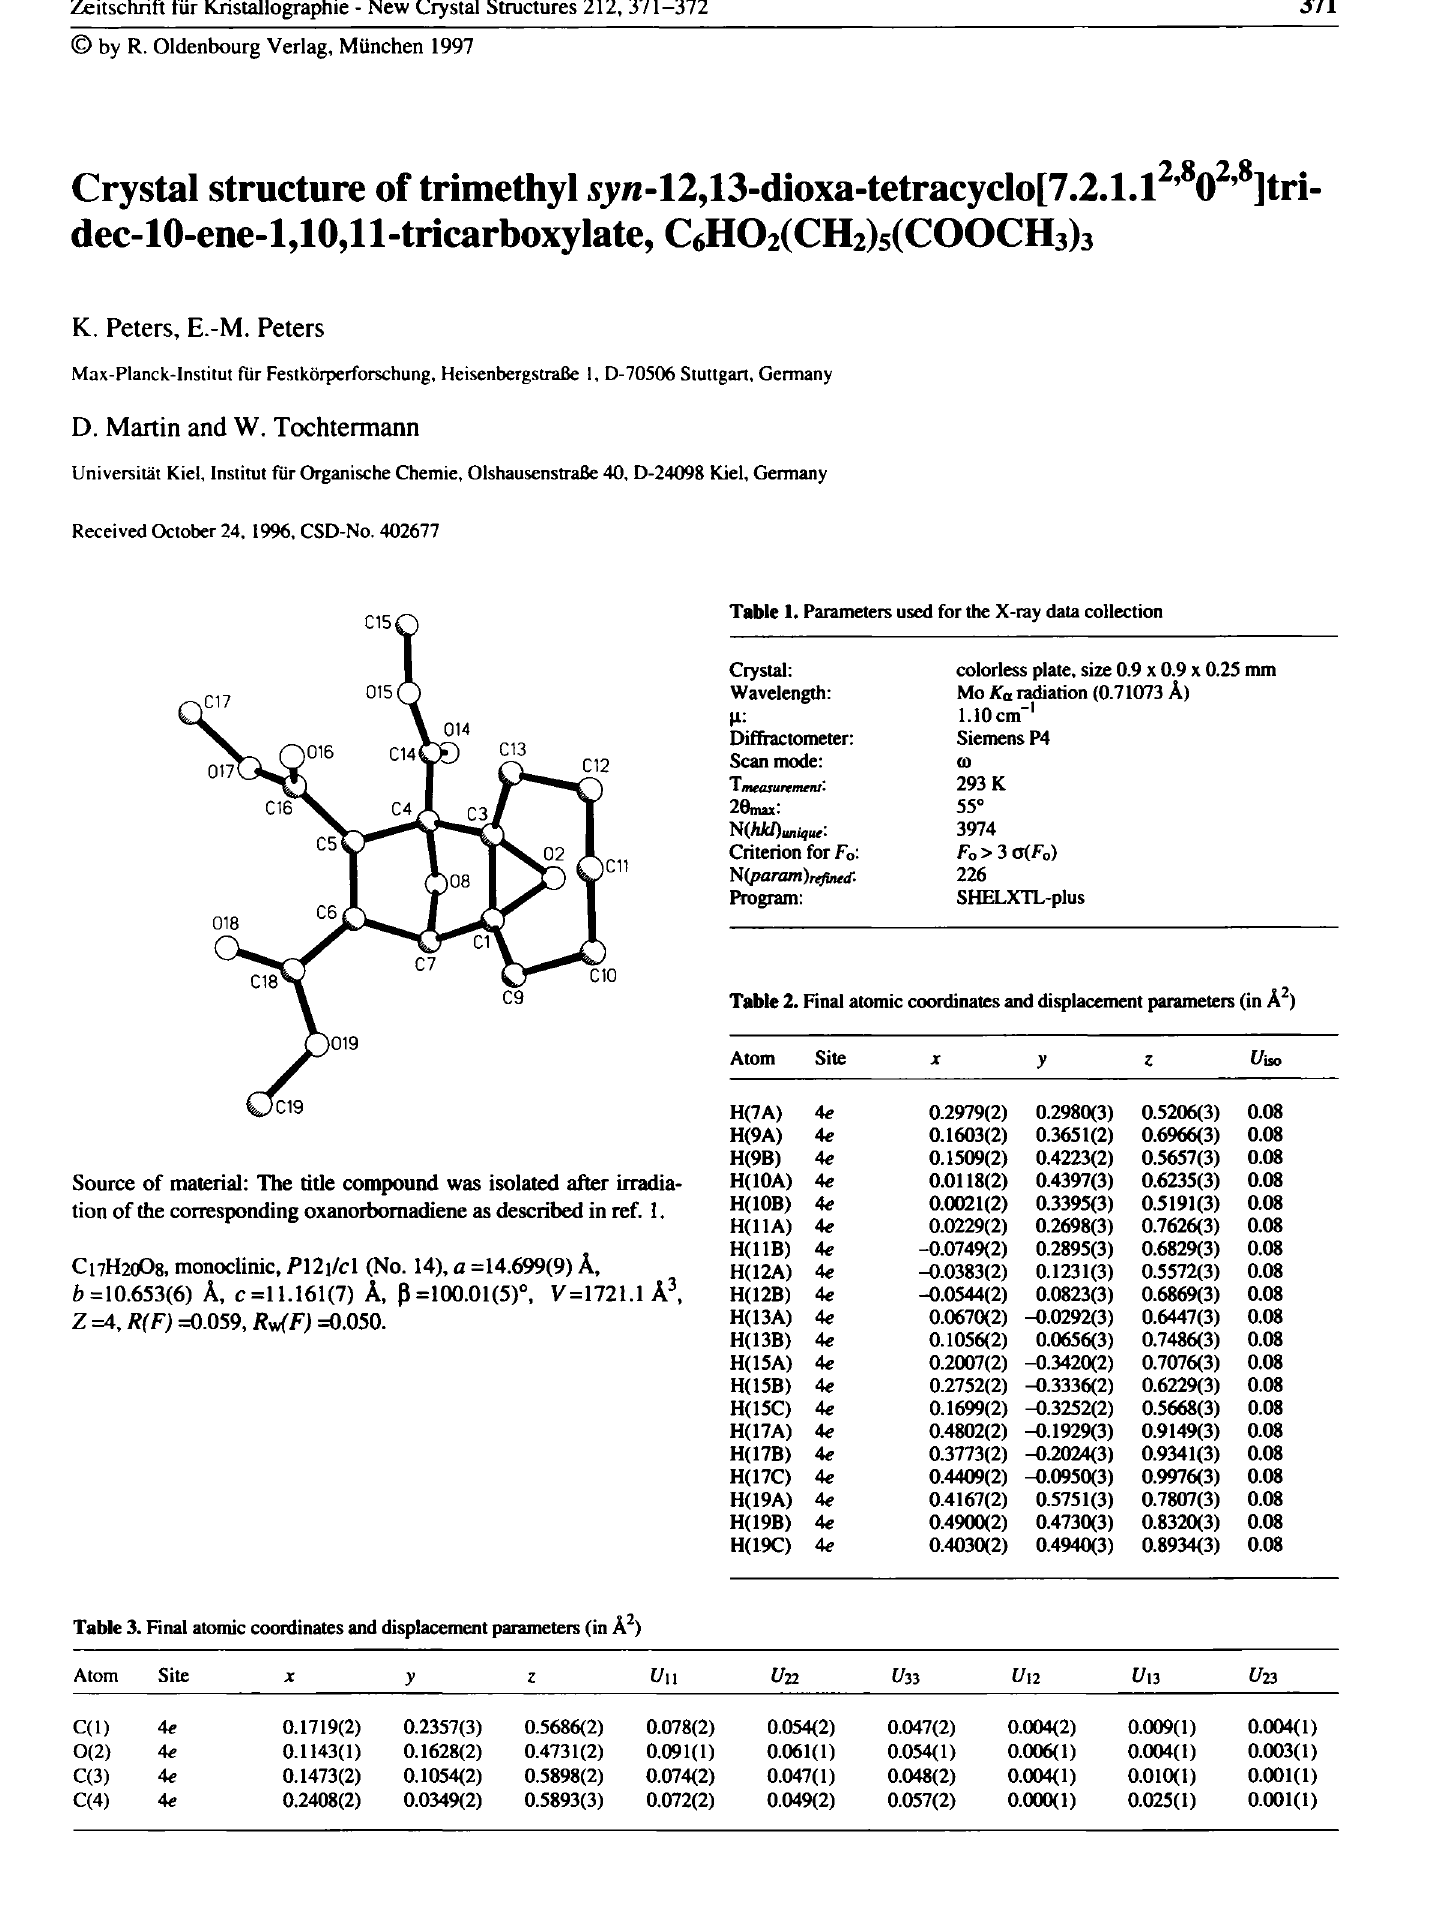
Table 3. Final atomic coordinates and displacement parameters (in Â 2 )